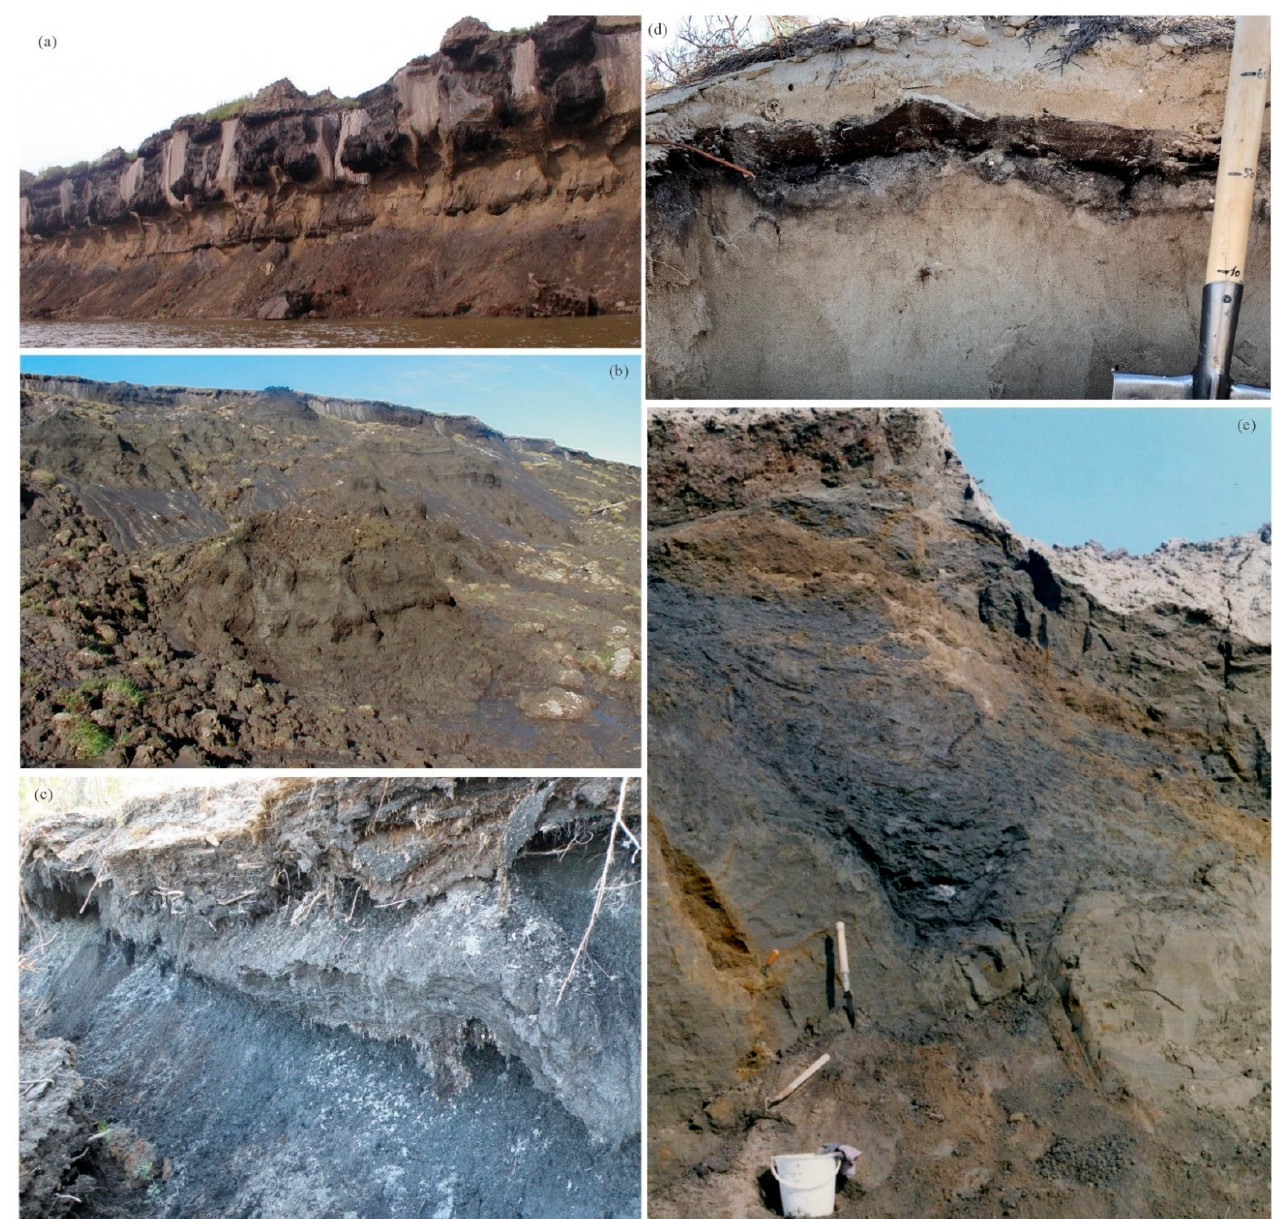
Figure 1. Sections where insects come from: ( a ) Kurungnakh Island in the Lena Delta, Pleistocene peat, ( b ) Bykovsky Peninsula (Yakutia), ice-rich section Mamontovy Khayata, ( c ) Undulung River (northern Yakutia), Holocene peat, ( d ) Kyzyl-Syr at the Viluy River, Yakutia, peat layer in the sand, ( e ) Bolshoy Laykhovsky Island, section Zimovie—lake sediment with ice wedge cast. This paper is focused on aquatic, riparian, and wetland insects with a solid chitin exoskeleton from the spacious ice-free land of Beringia (Figure 2). This land is stretched across the north-western part of North America and in the north-eastern part of Asia, including the Bering Strait (the Bering Land Bridge of the Pleistocene).